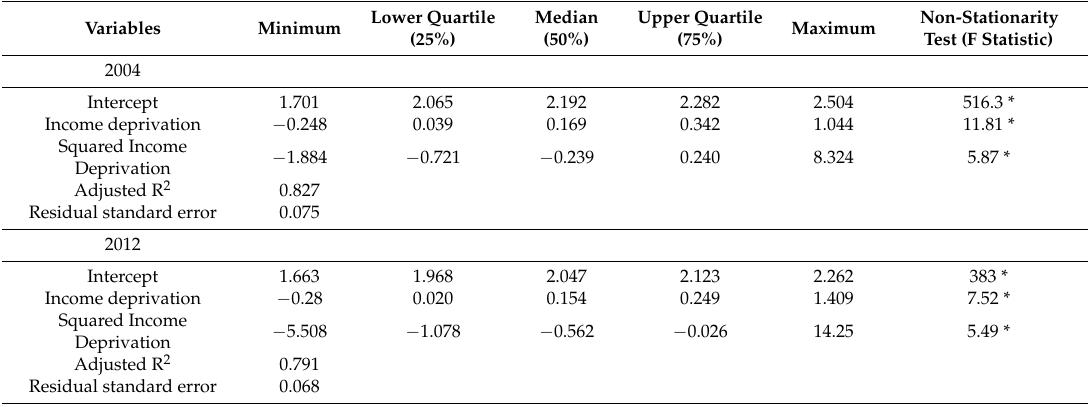
Table 3. GWR estimation results for 2004 and 2012.